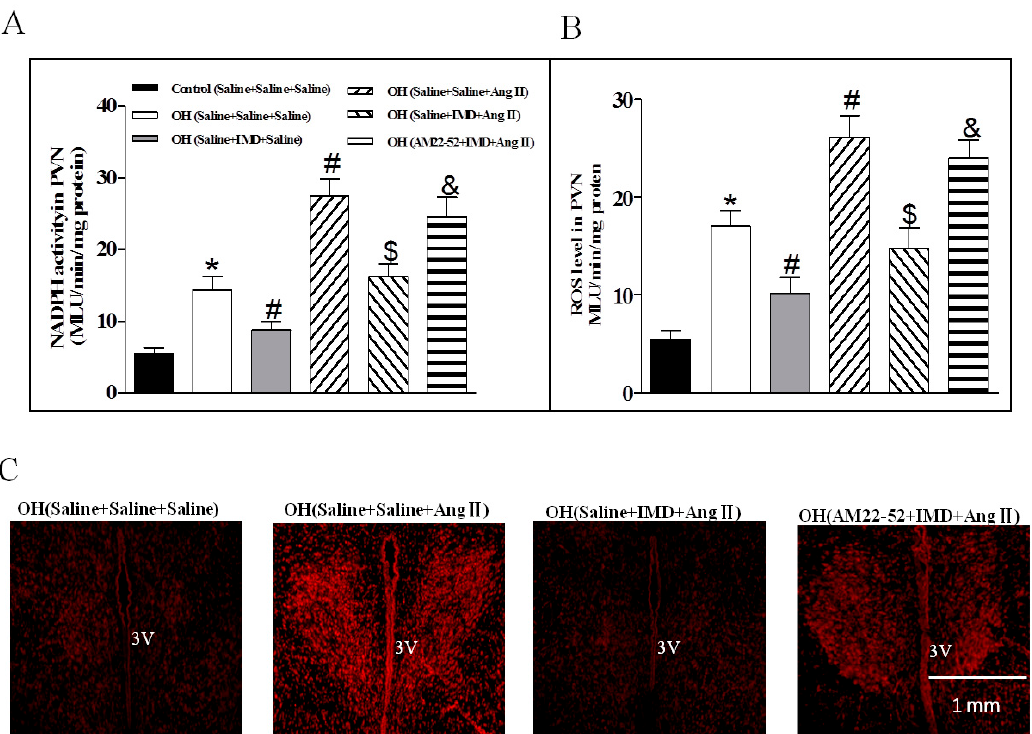
Figure 5. E ff ects of a PVN microinjection of saline, Ang II (0.3 nM) or IMD (50 pM) on NADPH oxidase activity and ROS levels in the PVN of OH rats; pretreatment of saline or IMD on Ang II-induced NADPH oxidase and ROS levels; and AM receptor antagonist AM22-52 pretreatment on IMD responses to Ang II-induced NADPH oxidase, ROS level and in situ ROS content in the PVN ( A–C ). Values are mean ± SEM. * p < 0.05 versus control (saline + saline + saline). # p < 0.05 versus OH (saline + saline + saline). $ p < 0.05 versus OH (saline + saline + Ang II). p < 0.05 versus OH (saline + IMD + Ang II). n = 6 or 7 for each group.